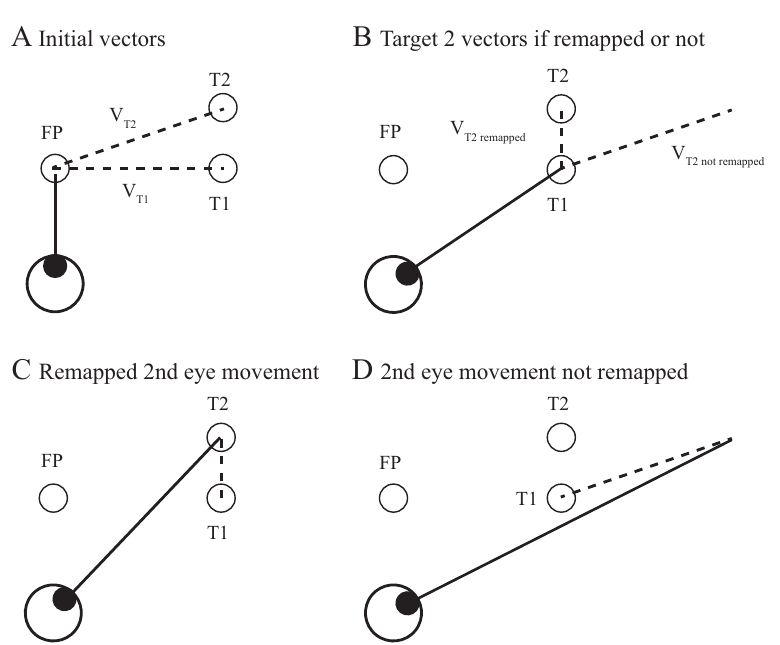
Fig 1. Double-step saccadetask. (A) Saccade vectors encodedduringinitial fixation periodfor both the first (T1) and second (T2) targets of the sequence.Both targets are presentedduringthe fixation periodand are extinguished before the onset of the first saccade. (B) Saccadevector of the second saccade of the sequence at the end of the first saccade of the sequence.(C) Successful acquisitionof T2 followingremappingof V T2 . (D) Large second saccade errors observedif no remapping is performed.FP = fixation point. T1 = target 1. T2 = target 2. V T1 = vector of first saccade.V T2 = vector of second saccade. Solid line = gaze direction. Dashedlines = encodedsaccade